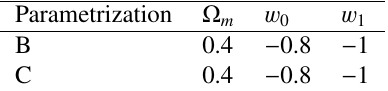
Table 3: Best fit values of Ω m , w 0 and w 1 for Parametrizations B and C